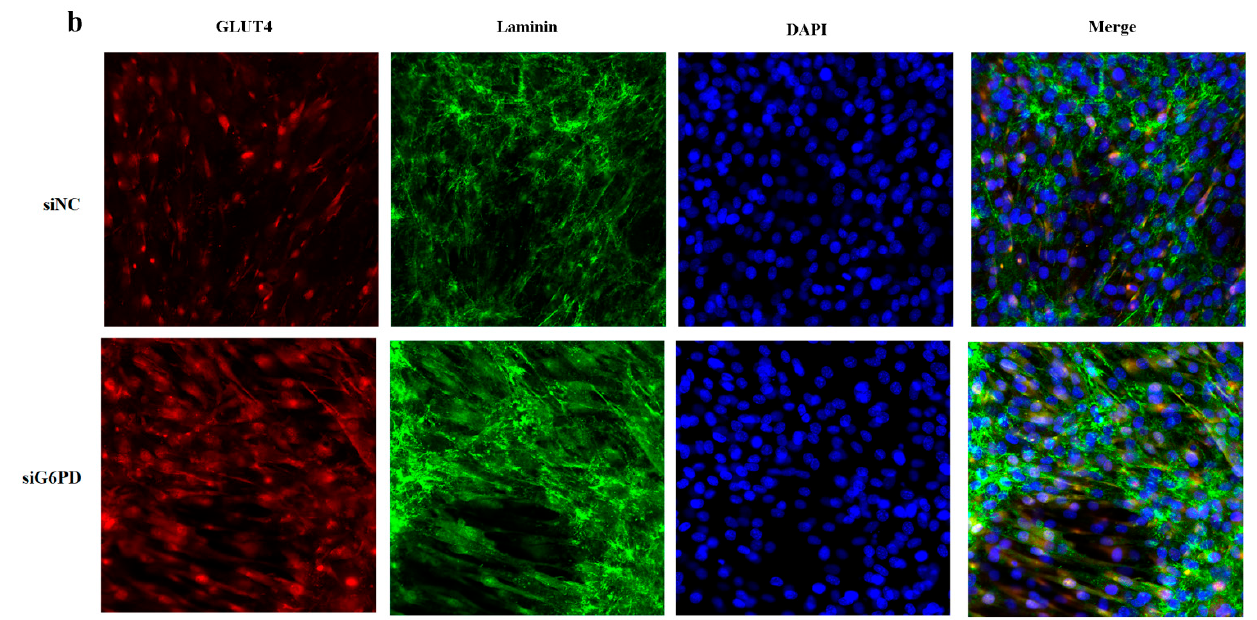
Figure 3. Knock down of G6PD promoted skeletal muscle cells’ response to insulin. ( a ) Western blot analysis for G6PD, GLUT4 and insulin signaling pathway associated protein after G6PD siRNA transfection with or without 100 nM insulin. ( b ) Immunofluorescence assay of GLUT4 translocation on cell membrane after G6PD siRNA transfection under 100 nM insulin; GLUT4 was stained as red, Laminin was stained as green and cell nuclei were stained as blue; scale bar = 50 µ m. ( c , d ) Flow cytometry assay of GLUT4 translocation on cell membrane after G6PD siRNA transfection under 100 nM insulin. ( e , f ) Flow cytometry assay for glucose uptake detection after G6PD siRNA transfection by 2-NBDG under 100 nM insulin. * p < 0.05, ** p < 0.01. MFI, median fluorescence intensity.